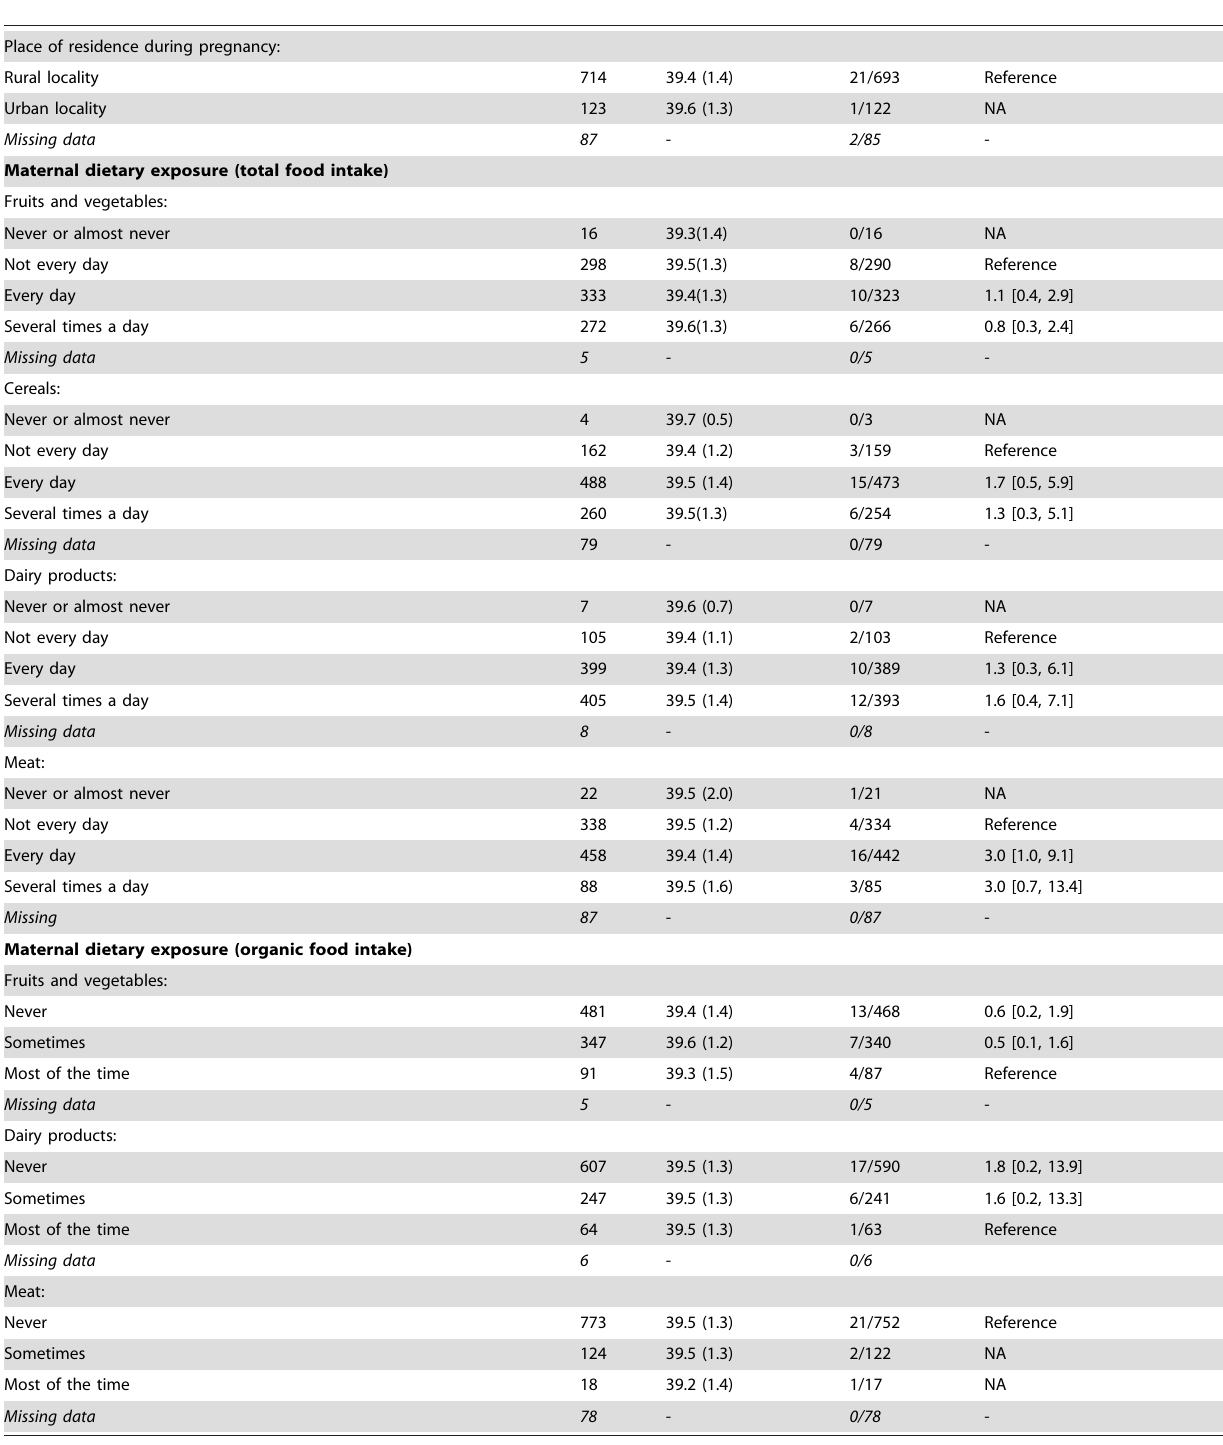
Table 6. Multivariate associations between factors related to in utero exposure to pesticides and gestational age and prematurity